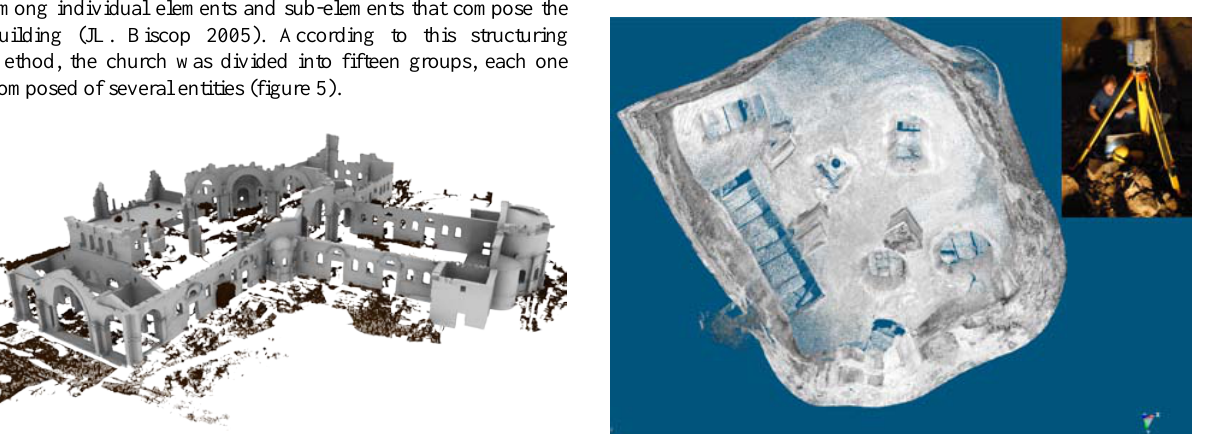
Figure 5. The representation for the phase of semantic description of the morphology of the church